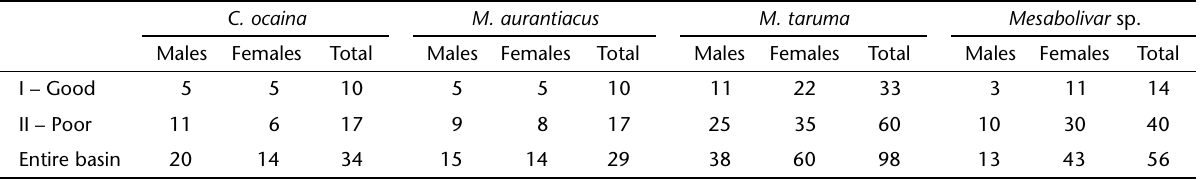
Table II. Abundances of the four most common Pholcidae species collected at Porto Urucu, Coari, Amazonas, Brazil, by sex class, forest gap types and the entire Amazon Basin.